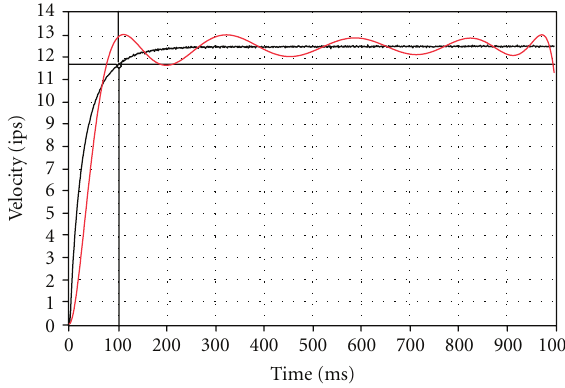
Figure 3: Approach w/o consideration of disturbance under 20volt input:Black, measurement: Red, power series